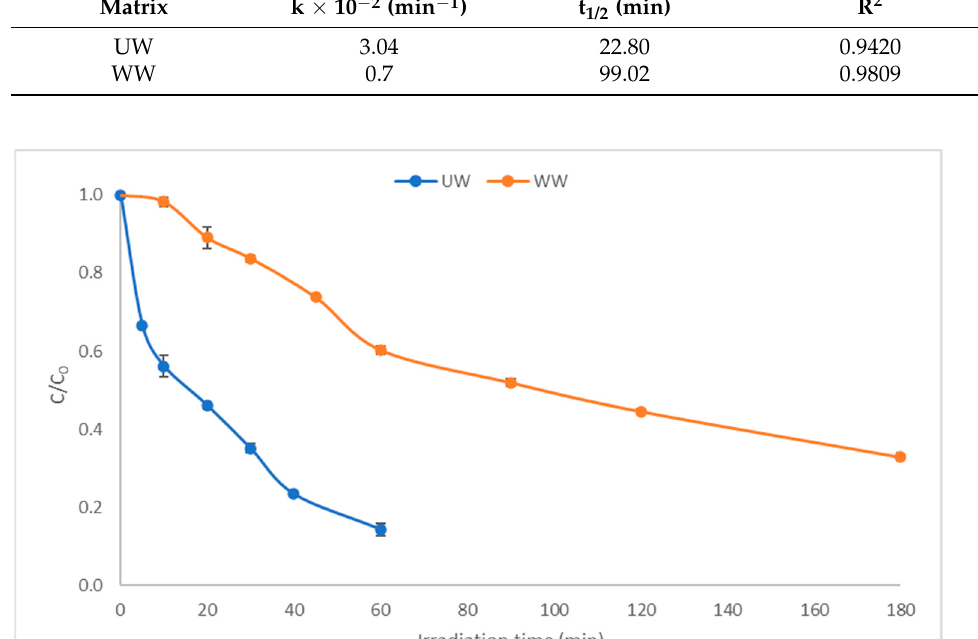
Figure 2. Photocatalytic degradation of amisulpride under UVA irradiation in UW and WW ([amisulpride] 0 = 1 mg L − 1 ; [g-C 3 N 4 ] = 300 mg L − 1 ). ([amisulpride] 0 = 1 mg L − 1 ; [g-C 3 N 4 ] = 300 mg L − 1